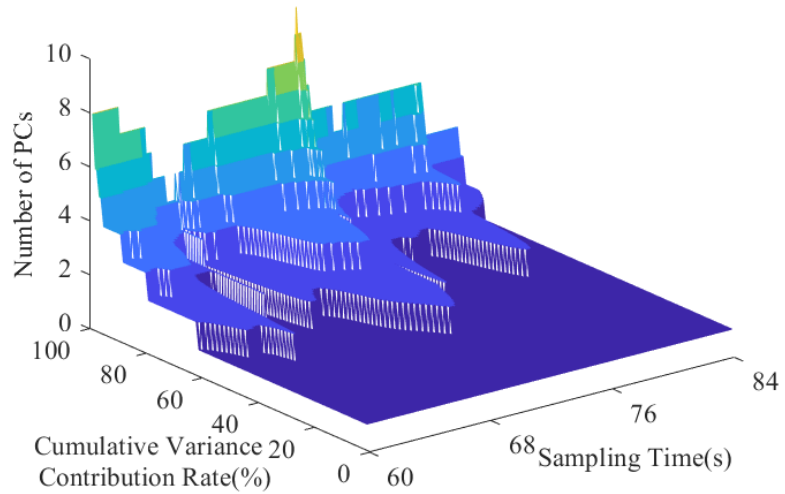
Figure 6. The number of principal components (PCs) of the real 34-PMU power flow data when different cumulative variance contribution rates are selected under the framework of